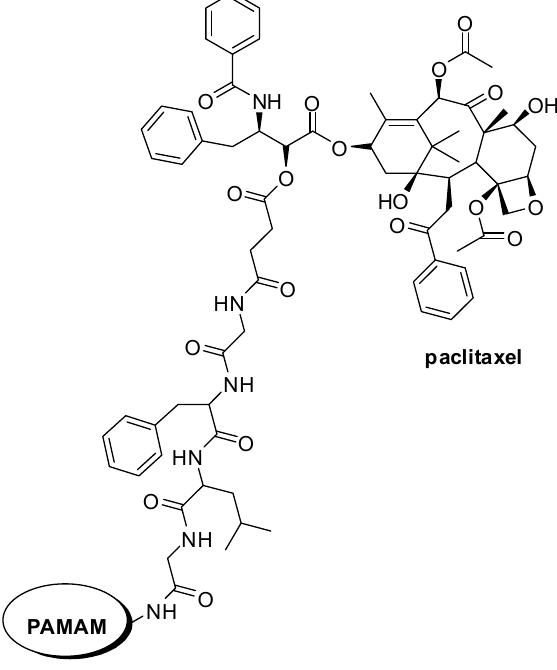
Figure 20. Targeted dendrimer designed for breast cancer therapy [81].